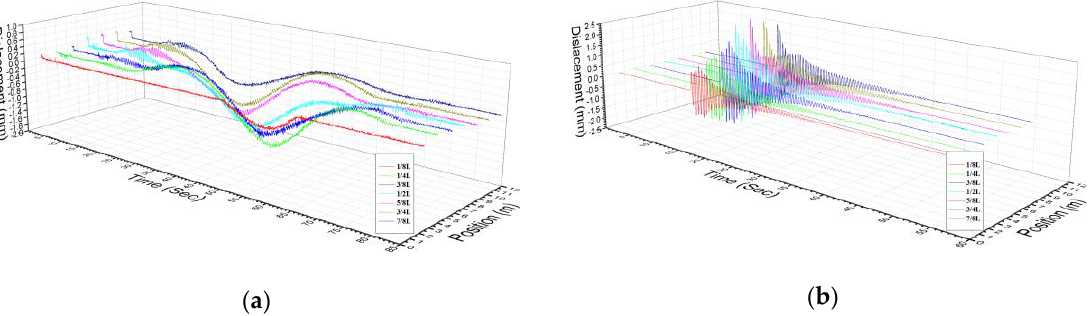
Figure 13. Results of all dial gauges measuring points by holographic visual sensor: ( a ) C test condition; ( b ) B test